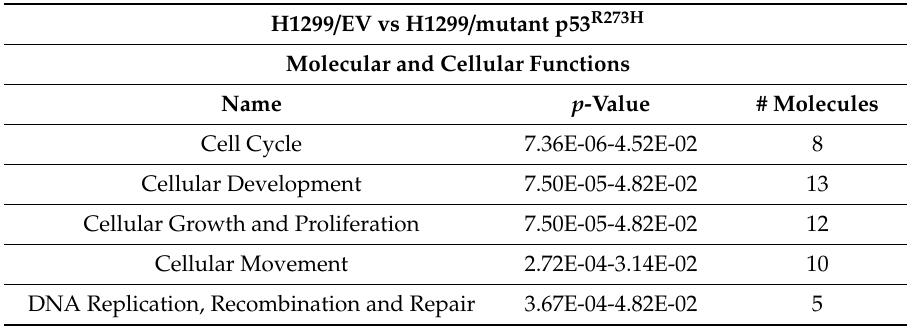
Table 2. Molecular and cellular functions enriched in H1299 / mutant p53 R273H